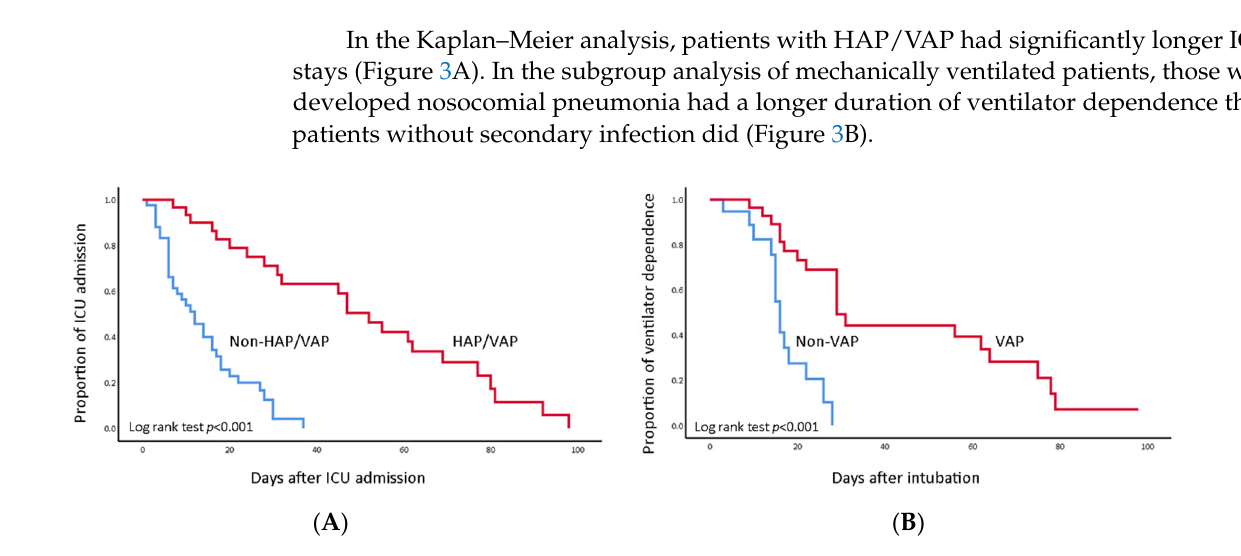
Figure 3. Kaplan – Meier curves for cumulative proportion of event. Red lines: HAP/VAP group; Blue lines: non-HAP/VAP group. ( A ) Patients with HAP/VAP had significantly longer times for ICU discharge (Log rank test: p < 0.001). ( B ) Patients with HAP/VAP had significantly longer durations of ventilator use (Log rank test: p < 0.001).